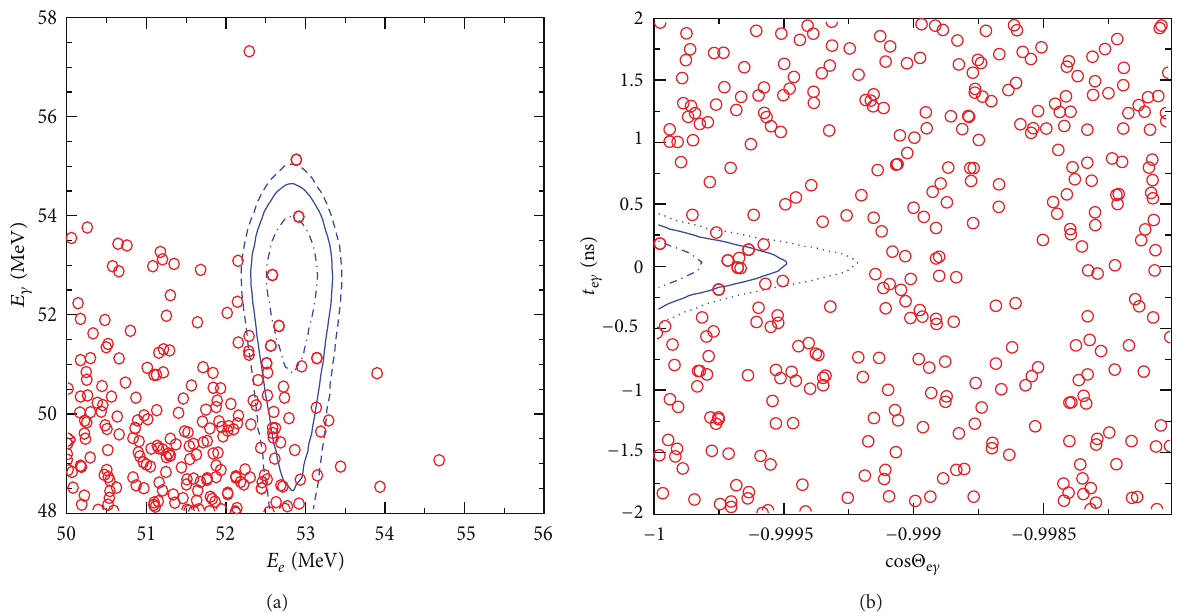
, 𝐸 ) (a) and in the ( cos ΔΘ 𝛾 e +